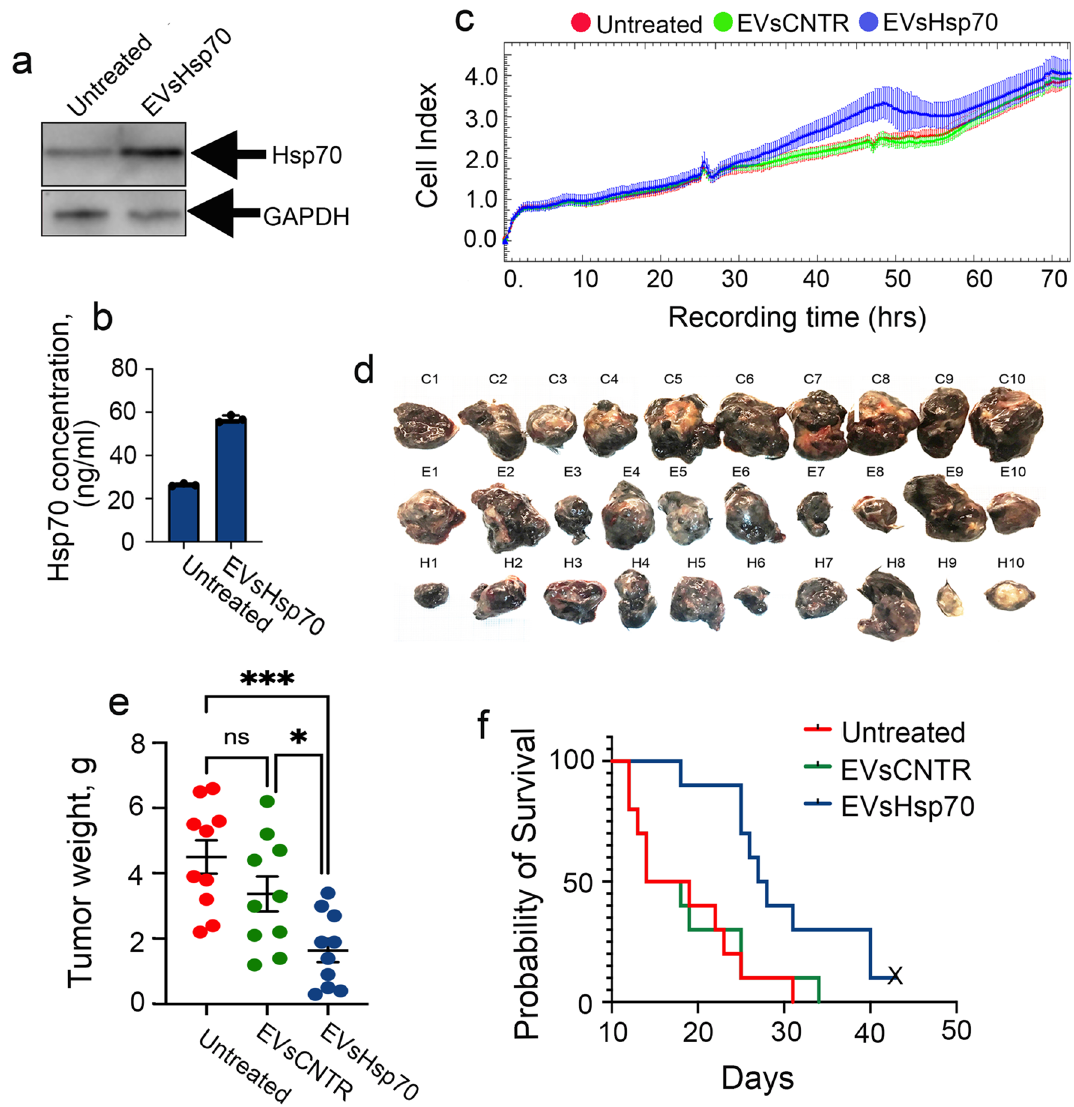
Figure 3. Hsp70-containing EVs do not affect B16 cell growth in vitro, but inhibit growth and increase survival rate of B16-bearing mice . The Hsp70 content in B16 cells, untreated and incubated with rHsp70 measured using ( a ) western blotting and ( b ) with a Hsp70-ELISA assay. A full-length blot images used to generate the panels on b are shown in Suppl Fig. S5. ( c ) EVs-CNTR or EVs-Hsp70 were added to B16 cells and their proliferation was measured using xCELLigence. B16 melanoma cells were used to inoculate C57Bl/6 mice, together with EVs-CNTR or EVs-Hsp70, after 19 days tumors were isolated, photographed ( d ) and weighed ( e ). *** p = 0.0006; *p = 0.0404, Dunnett’s multiple comparison test. ( f ) Cumulative proportion Kaplan–Meier curve. Survival was analyzed in the ’Untreated’ group (n = 10), ‘EVs-CNTR’ group (n = 10) and ‘EVs-Hsp70’ group (n =